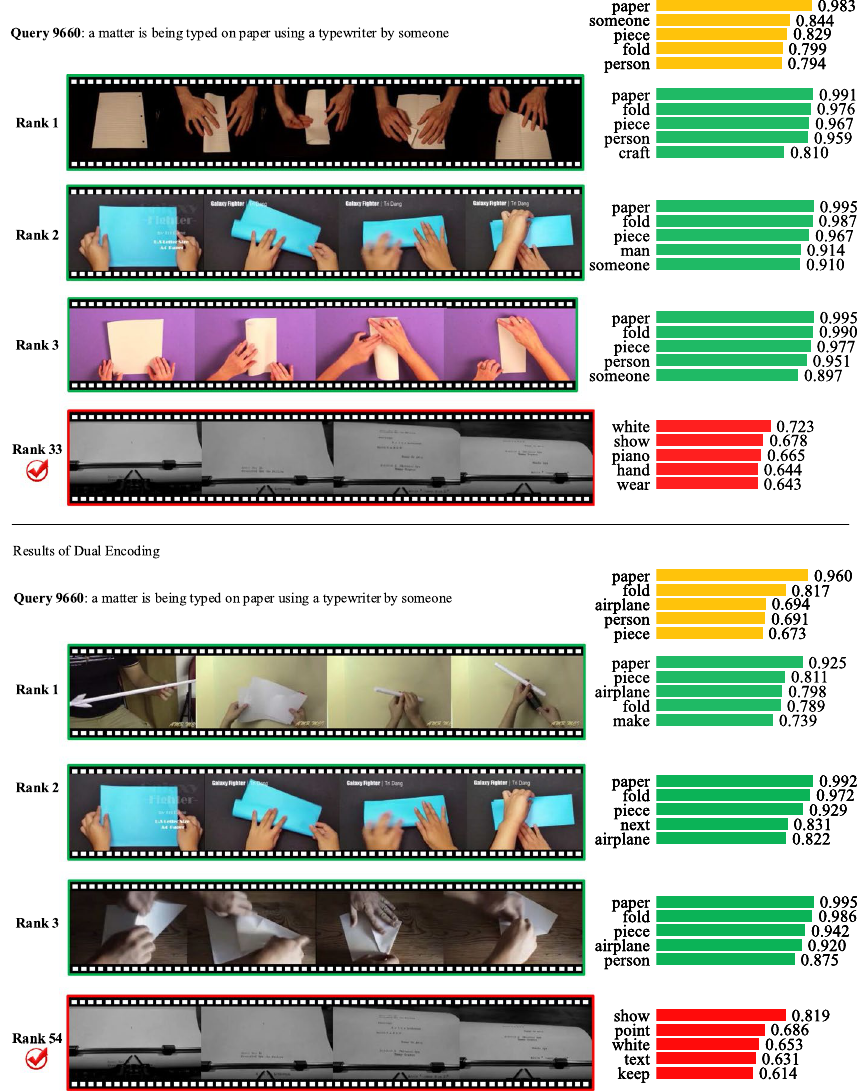
Fig. 4 The text-to-video retrieval results of our LADN and Dual Encoding on the MSR-VTT B partition [18]. The top 3 ranked videos and the ground truth are shown for each query. Additionally, the ground truth is marked with a red box, and the others are marked with a green box. The last column is the predicted concepts corresponding to the second